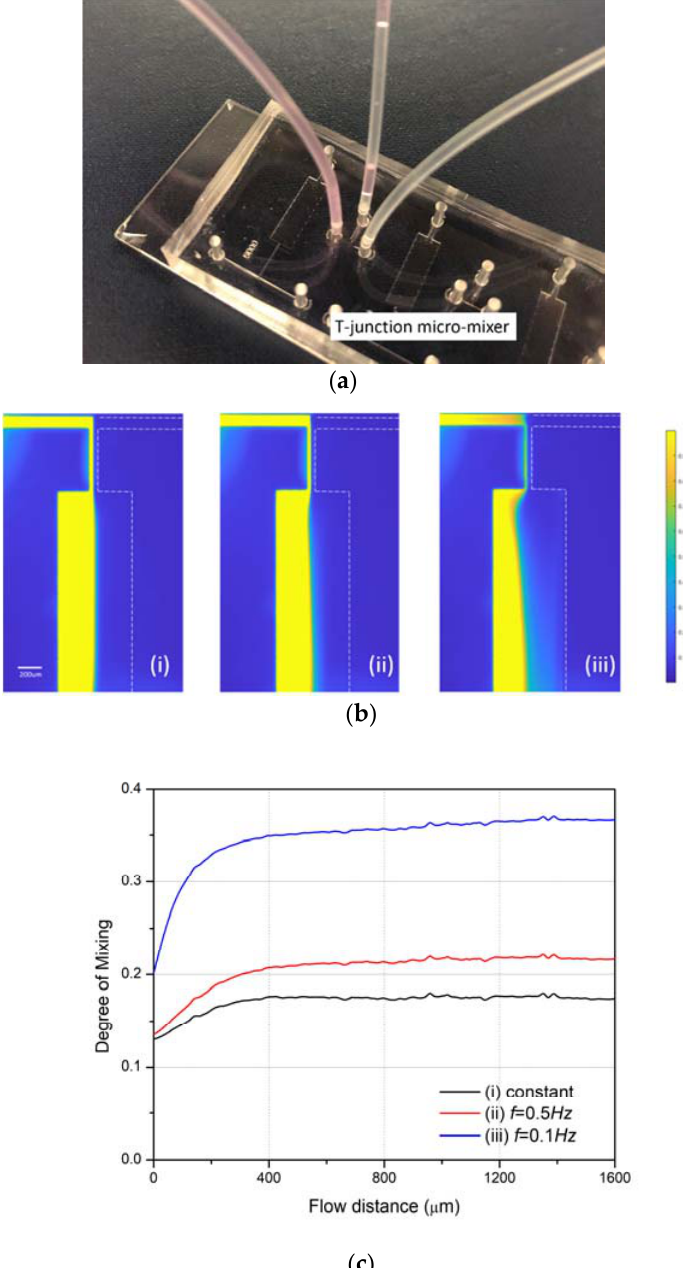
Figure 13. ( a ) The fabricated microfluidic chip for the T-mixer; ( b ) Recorded flow pattern of the glycerol solution with/without Rhodamine B on left/right side and the flow rate for right side ( i ) remains constant at 500 µL/h; ( ii ) alternates with frequency f = 0.5 Hz; ( iii ) alternates with frequency f = 0.1 Hz. ( c ) The measured degree of mixing for case ( i – iii ).